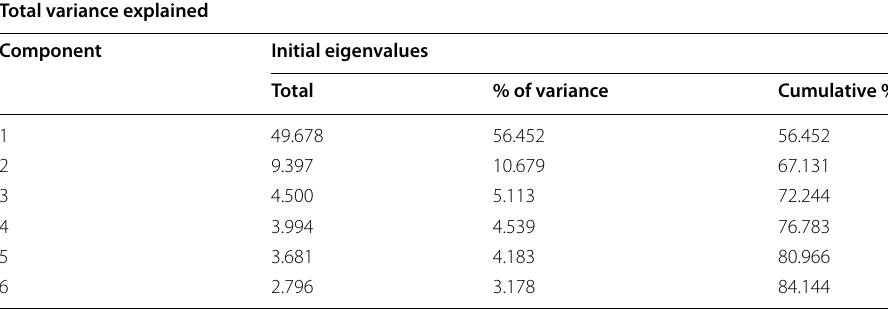
Table 6 The highest components of PCA for the third runs Total variance explained Component Initial eigenvalues Total % of variance Cumulative